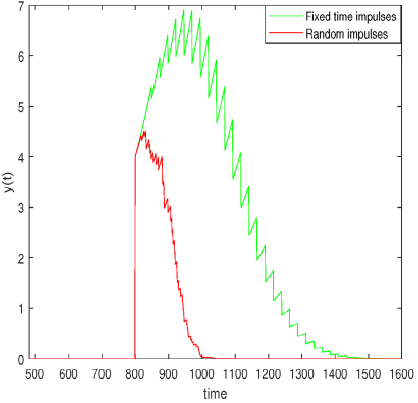
Figure 2. Comparative results between fixed and random time impulsive effects of system ( 23 )